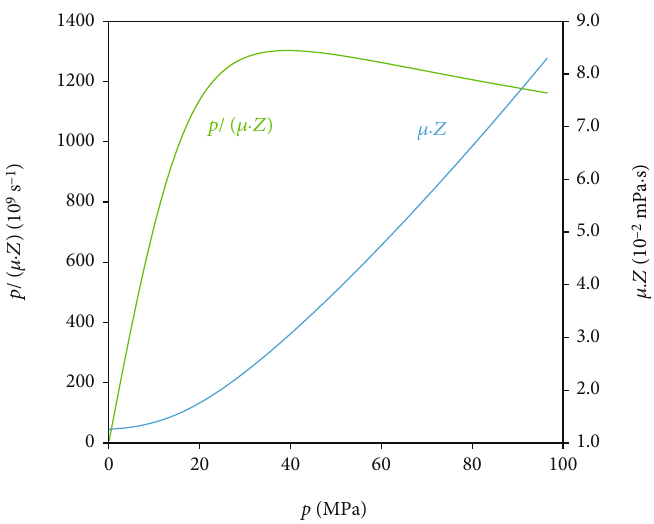
Figure 17: The relation curves of p / ð μ Z Þ and μ Z vs. pressure ( p ) for the fi eld case.